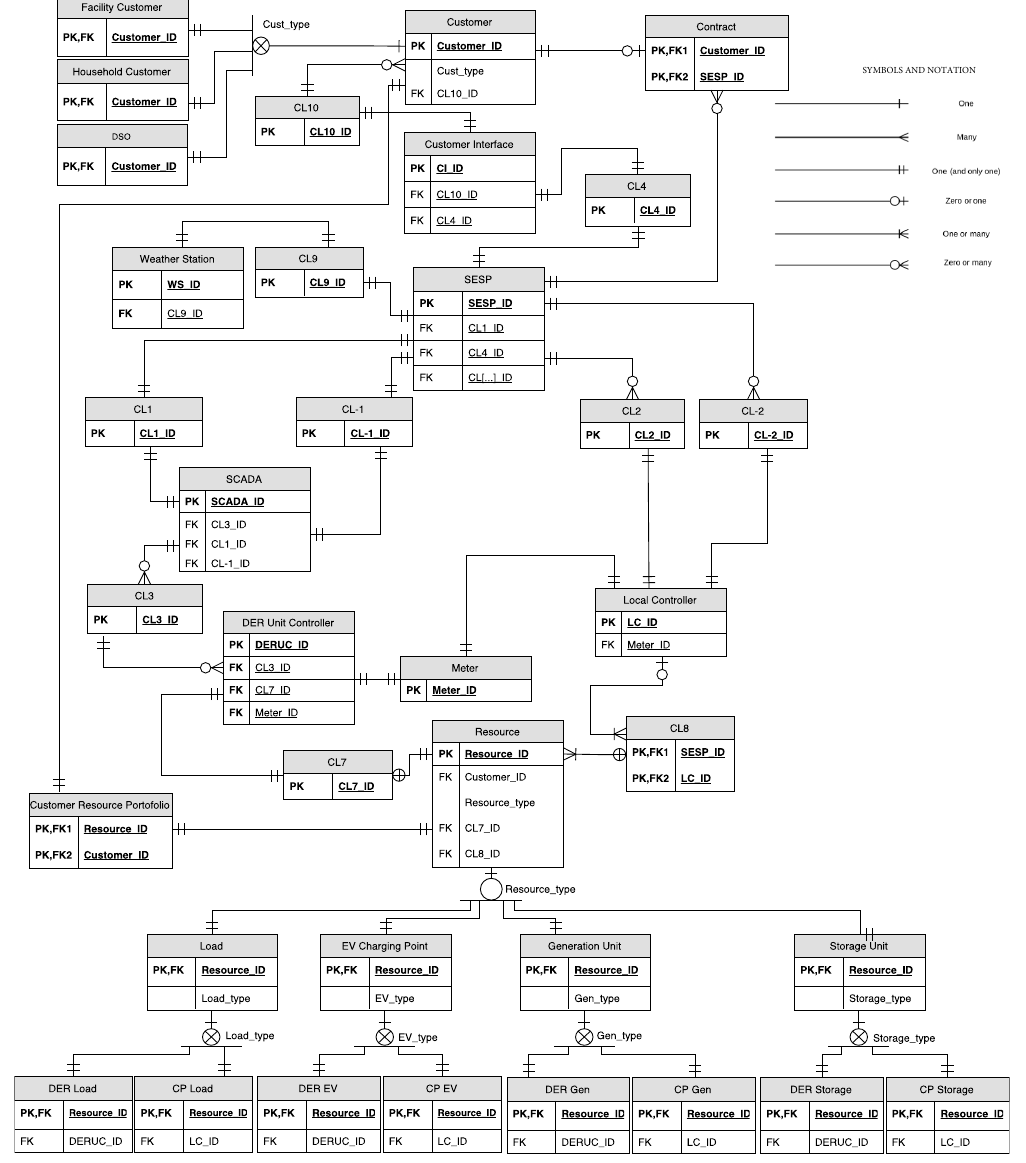
Figure 5. ER model of the EMPOWER smart distribution